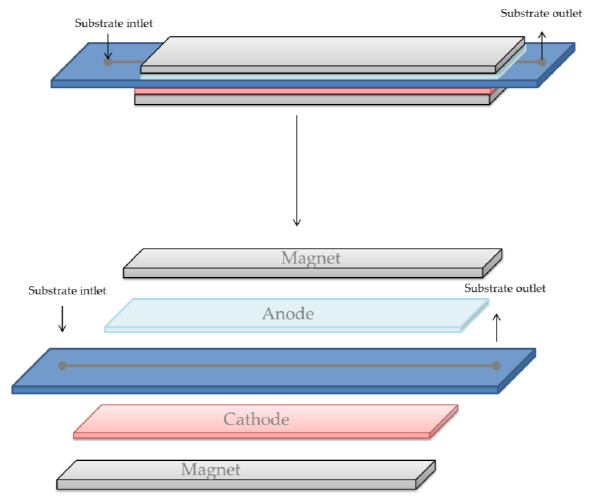
Figure 8. Microfluidic microbial fuel cell (MFMFC). Inspired by [124].